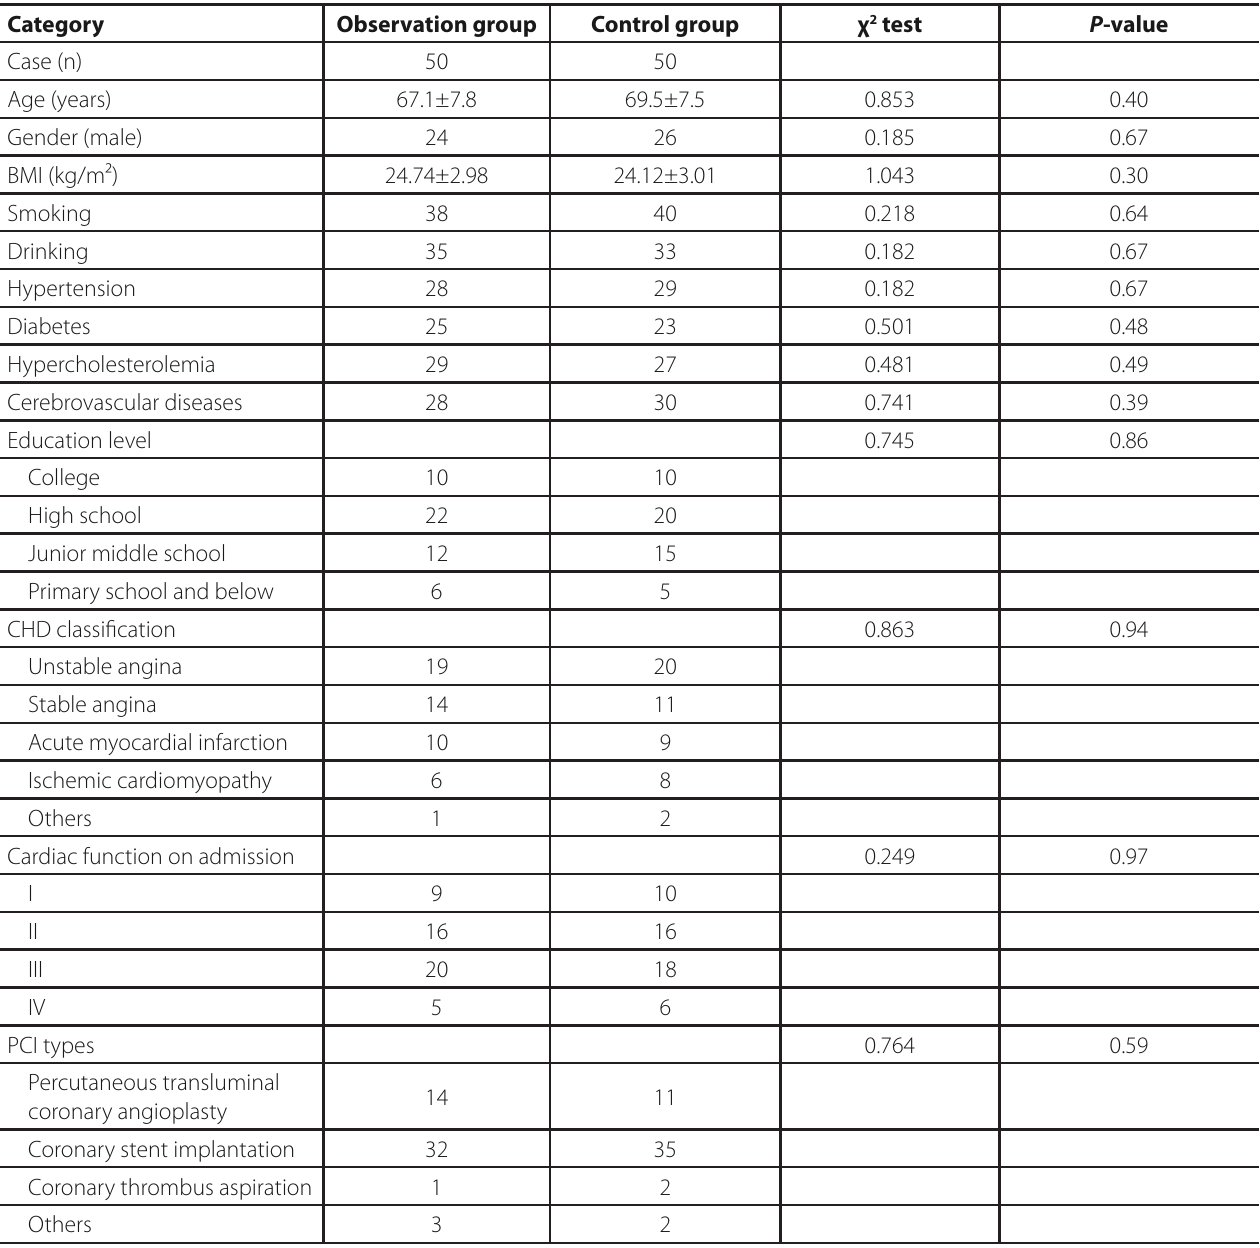
Table 1. Comparison of general information between the two